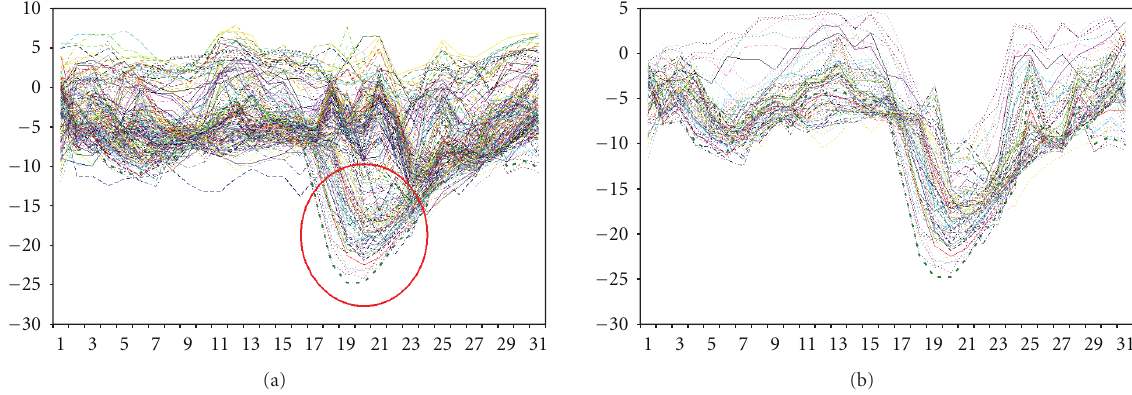
Figure 3: (a) The time series of the temperature at 2 m (C) at di ff erent grid points located over model domain. (b) The time series of the temperatures at di ff erent grid points with the fall in temperatures less than − 20 ◦ C during one-month period separated from Figure